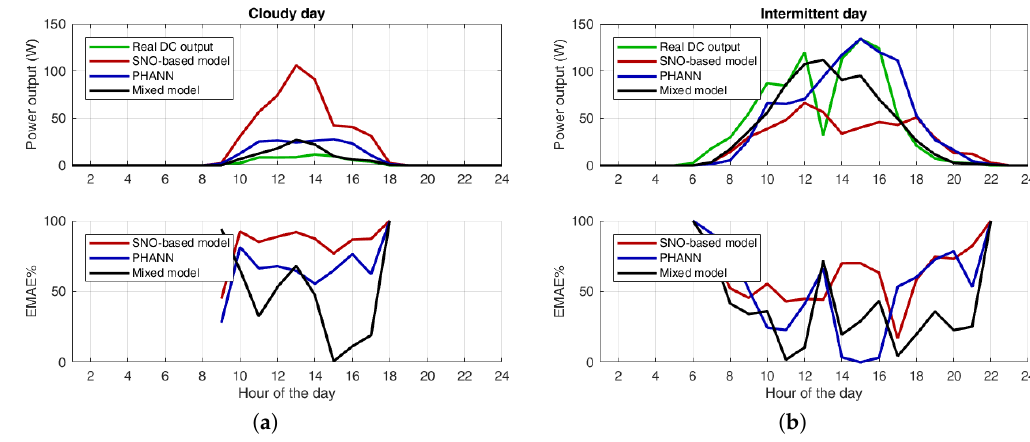
Figure 12. Comparison between the SNO-based model, the PHANN and the mixed model on a cloudy day and on an intermittent day in terms of power output and EMAE % error trend: ( a ) cloudy day; and ( b ) intermittent